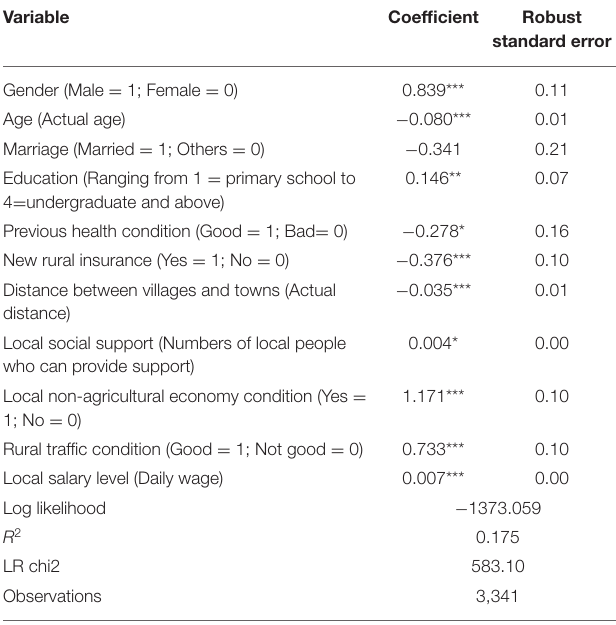
TABLE 5 | Propensity score estimation based on Logit model. Variable